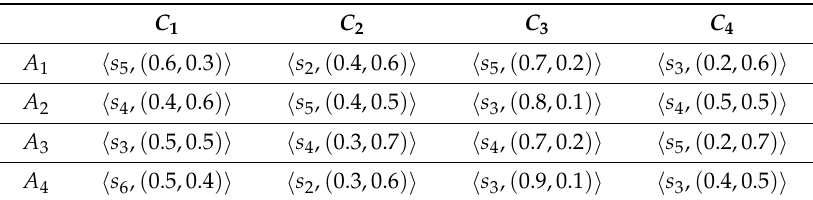
Table 1. Intuitionistic linguistic evaluation